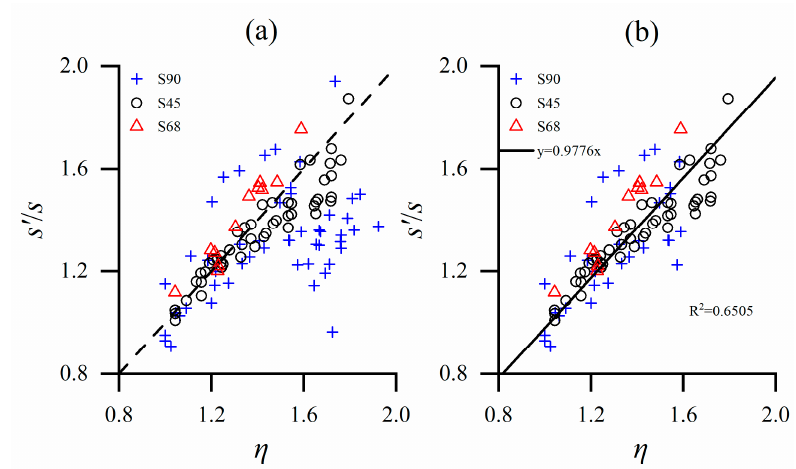
Figure 2. Relationship between S’/S calculated based on SF wm and η for smooth boundary cases: ( a ) comparisons between them, and ( b ) linear regression neglecting some data.